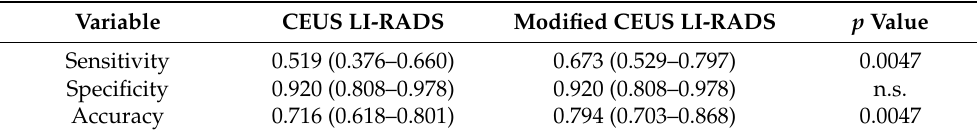
Table 5. Diagnostic performance of hepatocellular carcinoma diagnosis based on both LI-RADS and modified LI-RADS criteria.